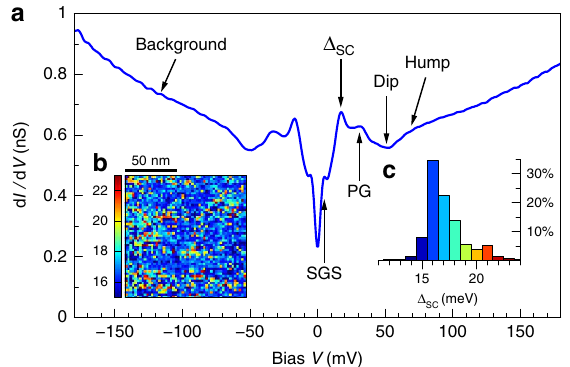
Figure 1 | Subgap states are observed in zero field. ( a ) Average d I /d V conductance of a 120 (cid:3) 120nm 2 area at T ¼ 0.4K in zero field. The junction resistance was 1.2G O and the regulation voltage 300mV. Five electron- hole symmetric spectral features and the background are indicated. ( b ) Spatial map of the superconducting gap D SC over the same area. ( c ) Histogram of the gap values shown in b . The colouring of bars corresponds to the colour scale shown in b . NATURE COMMUNICATIONS|7:11139|DOI: